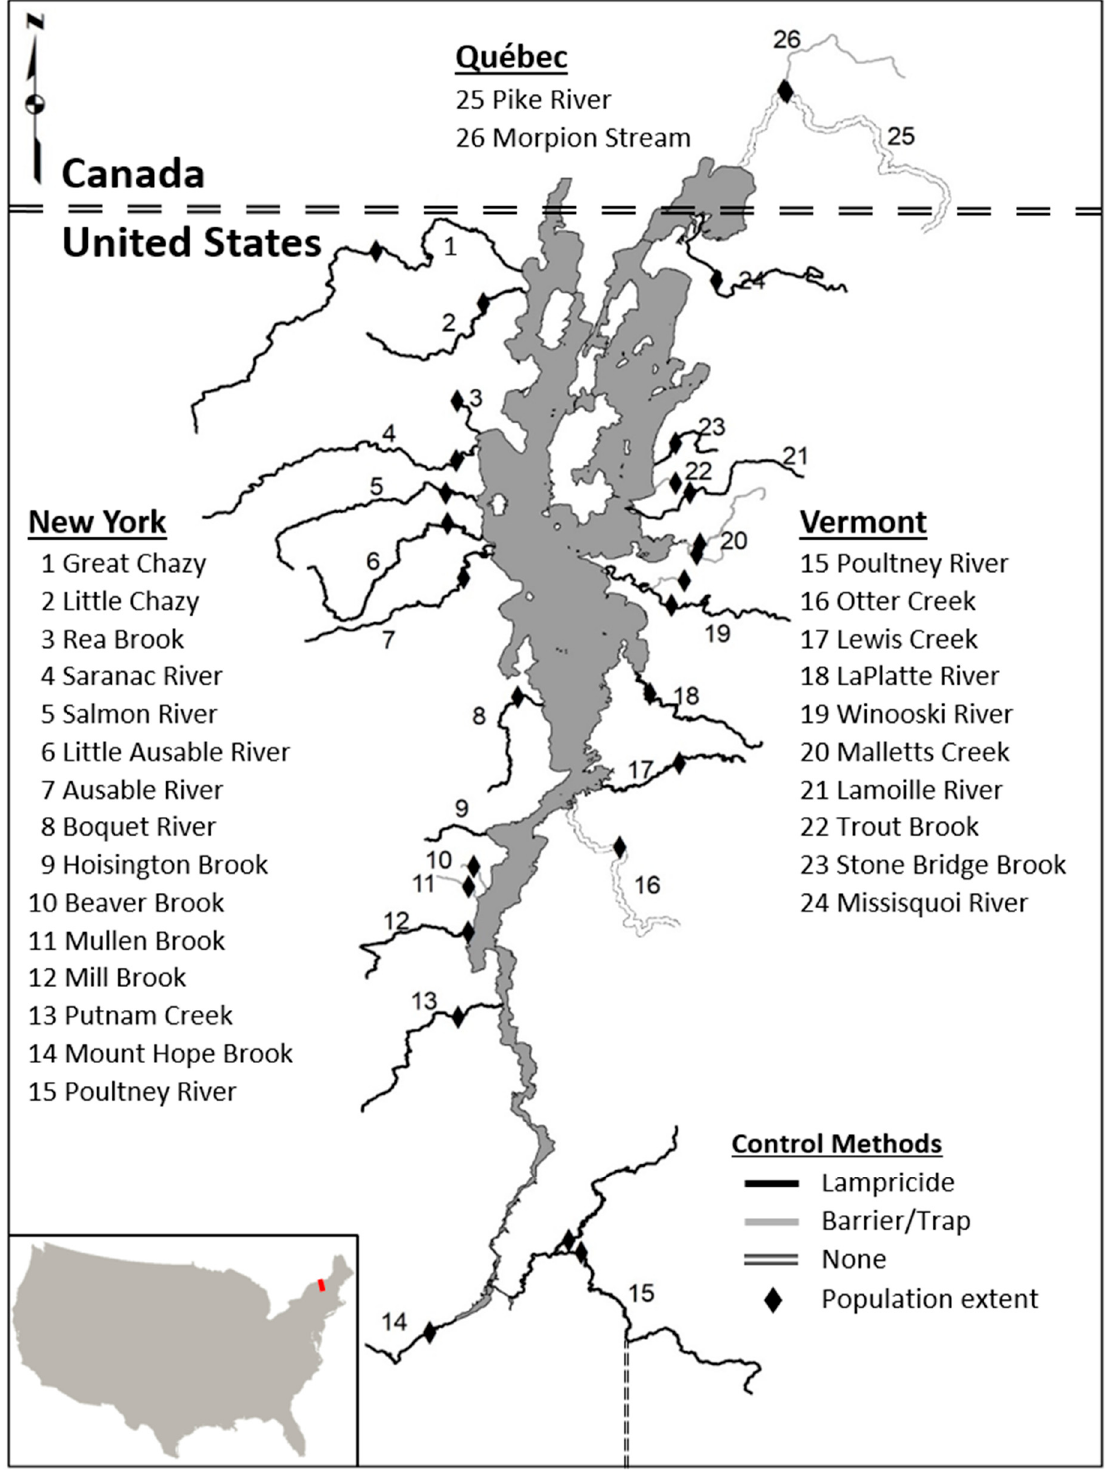
Figure 1. Lake Champlain and its 26 tributaries with currently known larval sea lamprey populations, controlled as indicated. The lake map represents the red-colored region on the inset United States map. Lamprey-producing subordinate tributaries controlled concurrently with mainstem tributaries are not included in counts.